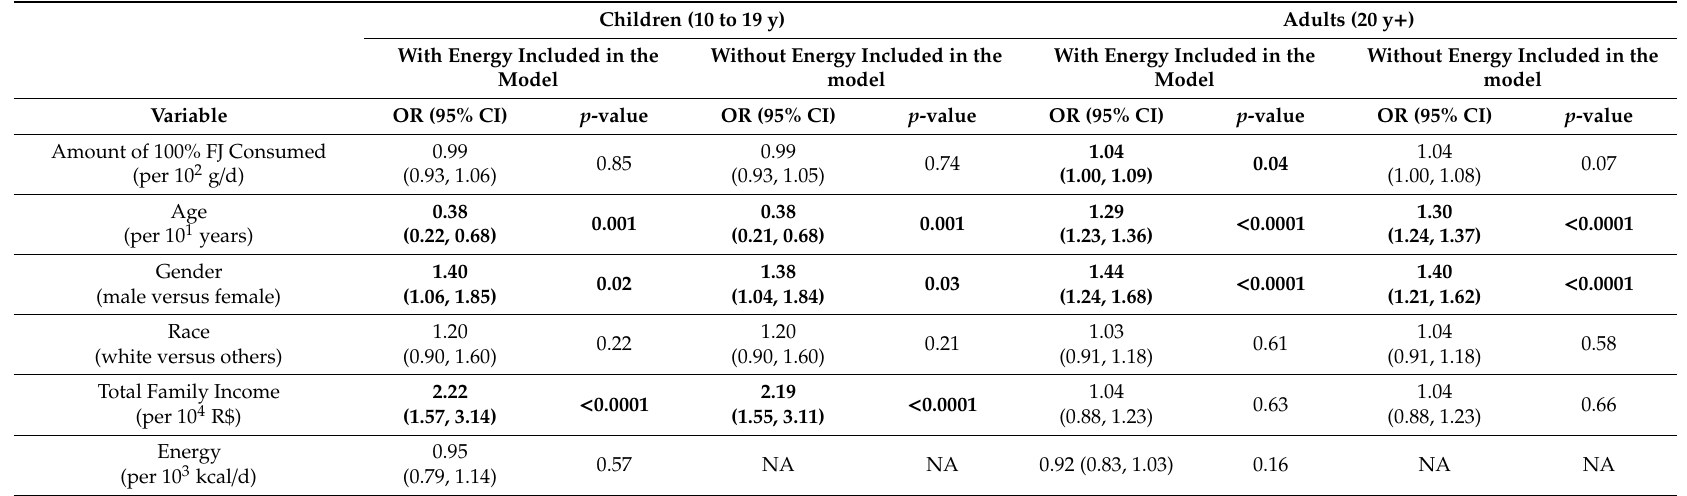
Table 5. The odds of being overweight or obese (versus underweight or normal weight) with the consumption of 100% FJ in Brazilians reporting the consumption of 100% FJ in the Brazil POF (2008–2009): results of multiple logistic regression